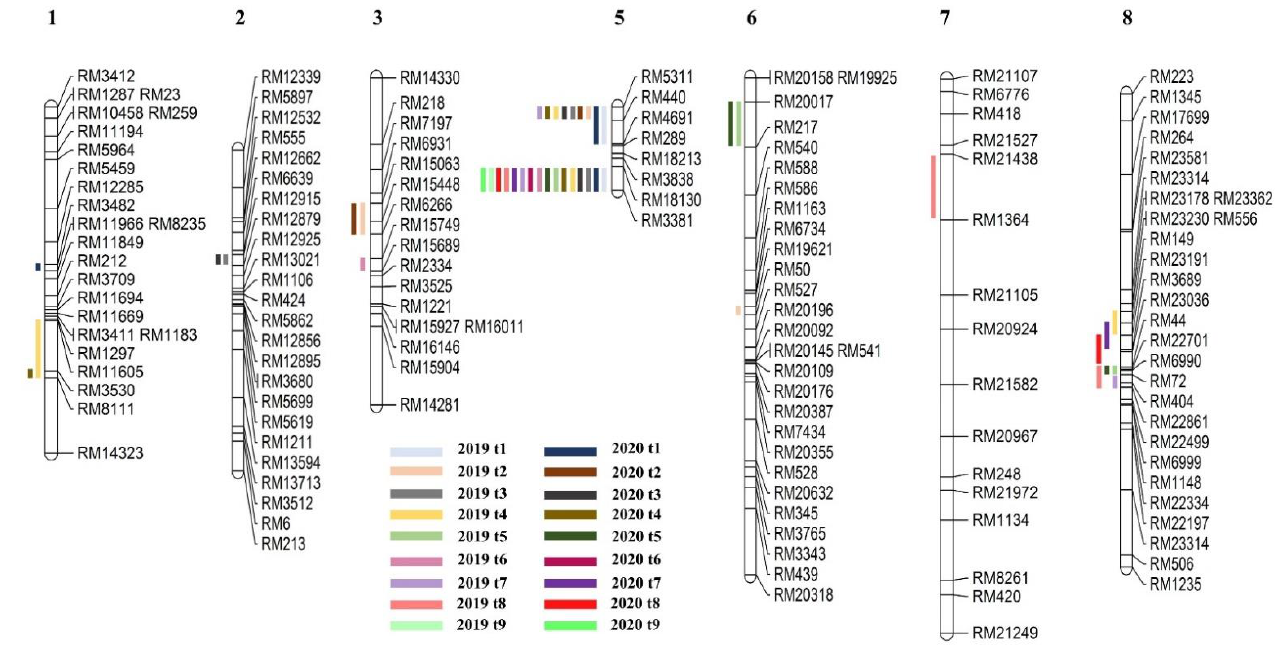
Figure 5. Chromosomal location of QTL related to tiller number at different growth stages in the CNDH lines.